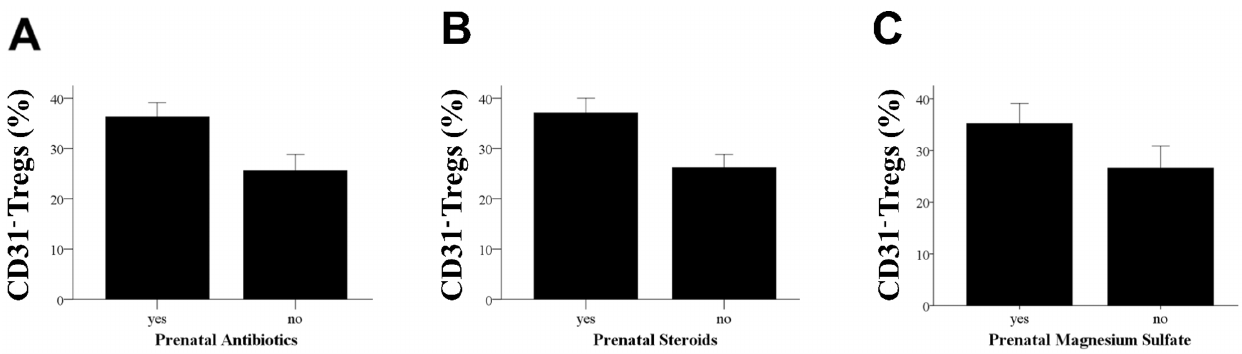
Figure 4. Maternal factors affect the percentages of Treg phenotypes in CB. ( A ) Column bar graph comparing median and confidence intervals of the percentage of CD31 2 Tregs in infants (both term and preterm) whose mothers had received prenatal antibiotics. ‘‘Yes’’ indicates mother received prenatal antibiotics and ‘‘No’’ indicates no antibiotics were given. Statistical significance was determined by Mann-Whitney U test (*p , 0.0001). ( B ) Column bar graph comparing median and confidence intervals of the percentage of CD31 2 Tregs in infants (both term and preterm) whose mothers had received prenatal steroids. ‘‘Yes’’ indicates mother received prenatal steroids and ‘‘No’’ indicates no steroids were given. Statistical significance was determined by Mann-Whitney U test (*p , 0.0001). ( C ) Column bar graph comparing median and confidence intervals of the percentage of CD31 2 Tregs in infants (both term and preterm) whose mothers had received prenatal magnesium sulfate. ‘‘Yes’’ indicates mother received prenatal magnesium sulfate and ‘‘No’’ indicates no magnesium sulfate was given. Statistical significance was determined by Mann-Whitney